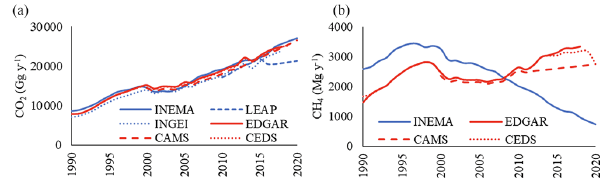
Figure 9. Comparison of PM 2 . 5 (a) and BC (b) emissions between this work (INEMA) and other local and global